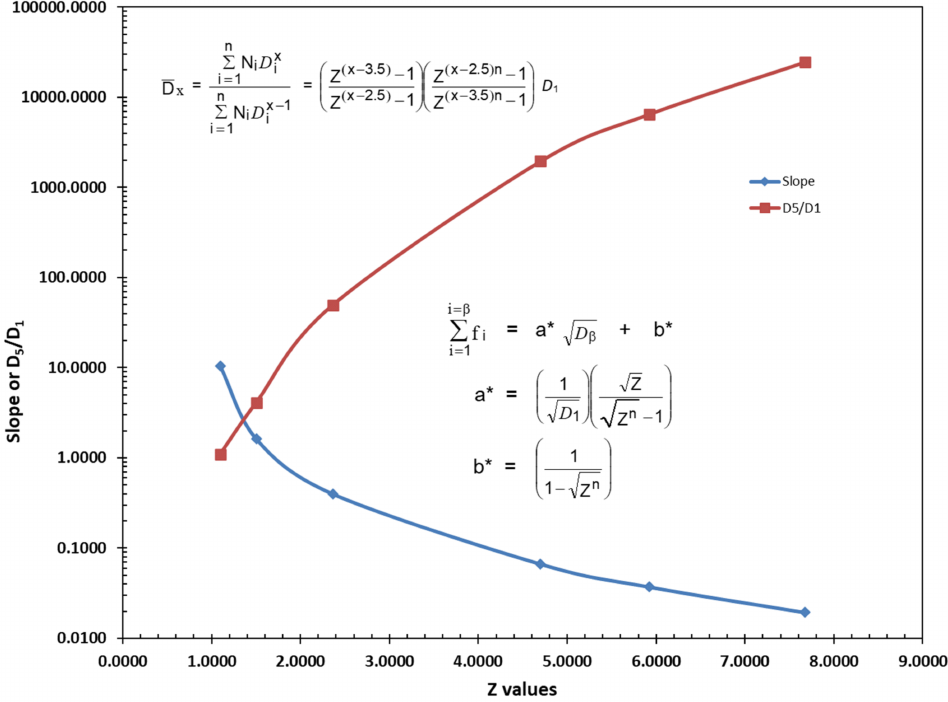
Figure 9. Slope and D 5 /D 1 vs. 6 different Z